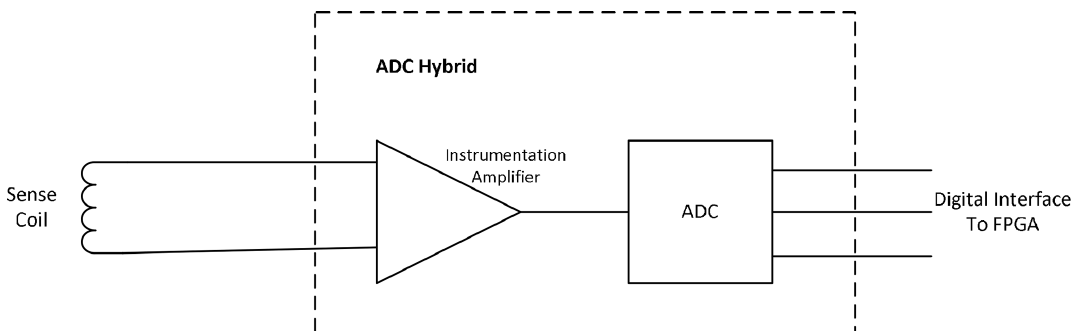
Figure 4. The block diagram of the sensing signal acquisition